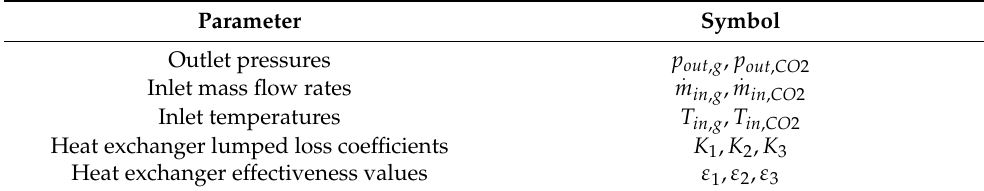
Table 1. Input feature parameters for the heat exchanger network.